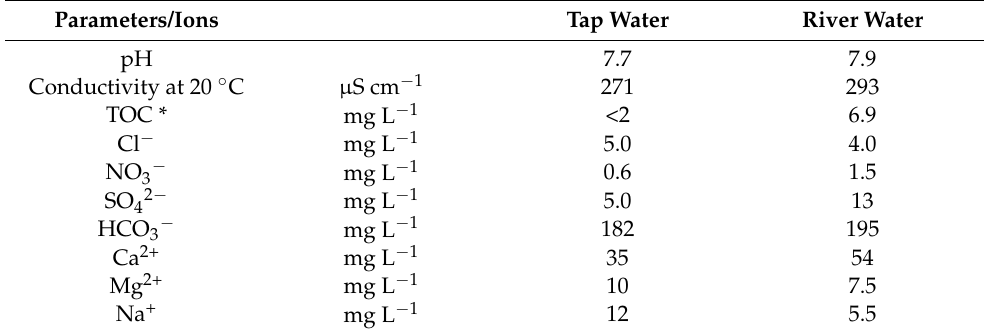
Table 1. Physico-chemical characterization of tap and river water